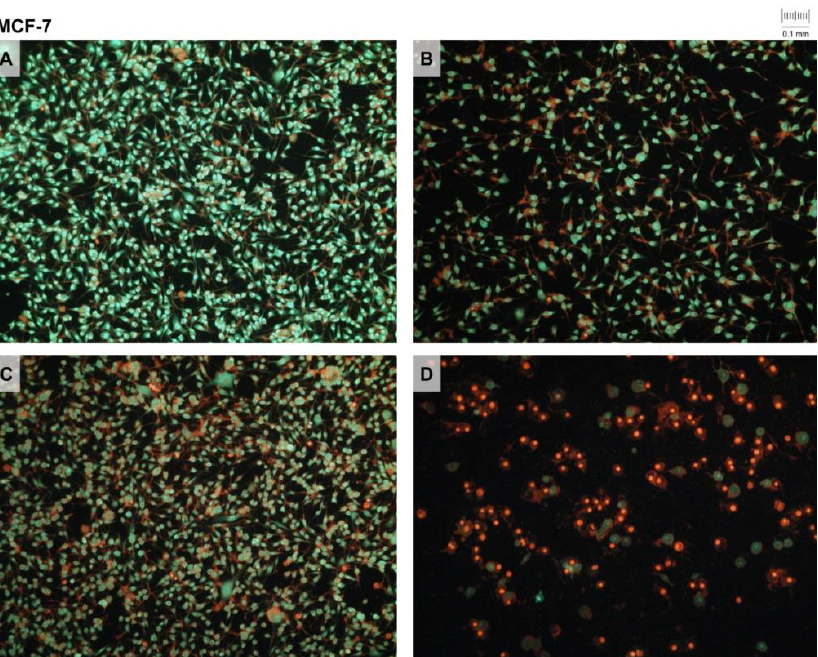
Figure 4. Double fluorescent staining of HeLa cell samples after 24 h treatment with extracts (DE, SWE) and resveratrol (RSV): control ( A ), dry extract ( B ), subcritical water extract ( C ) and resveratrol ( D ). Stained cells were photographed with an Olympus Camedia 3040 digital camera mounted on an Olympus BX51 microscope with a 10× magnification lens. Different intensities of fluorescent sig- nals of the two colors can be observed.